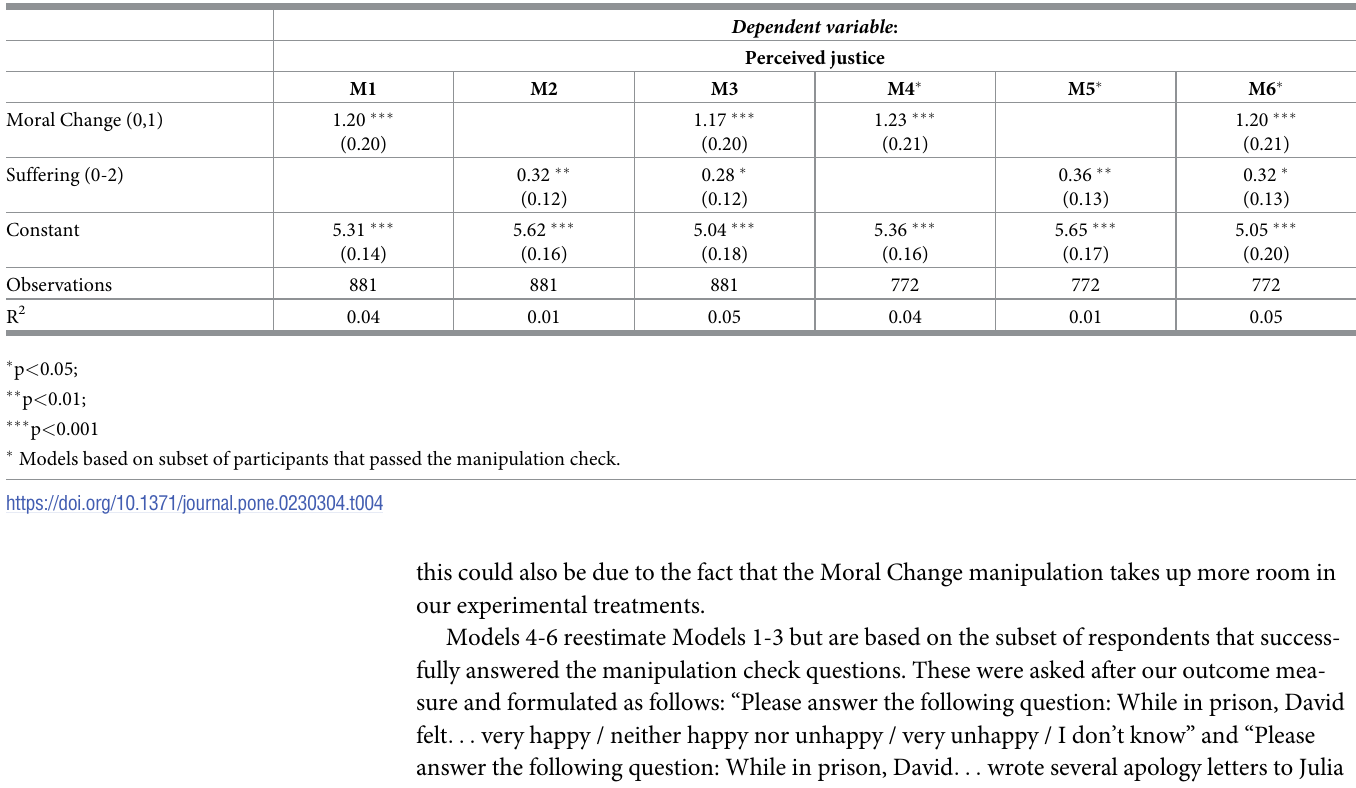
Table 4. Linear regression with and without manipulation